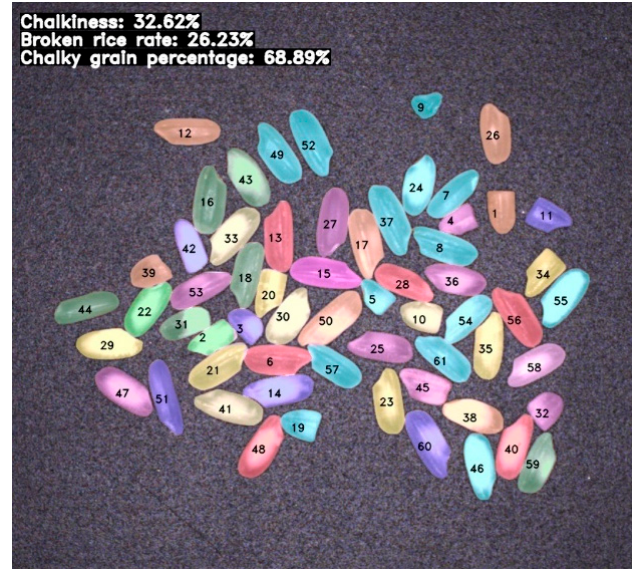
Figure 12. Image visualization of multiple rice grains.